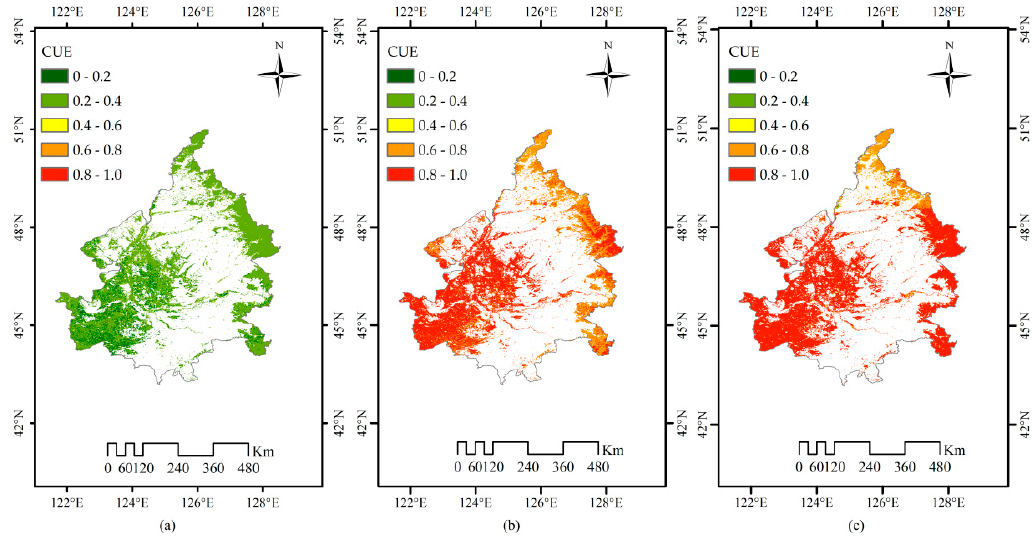
Figure 6. Spatial distribution of seasonal average CUE of the SNP from 2001 to 2015. ( a ) Spring; ( b ) summer; ( c ) autumn.